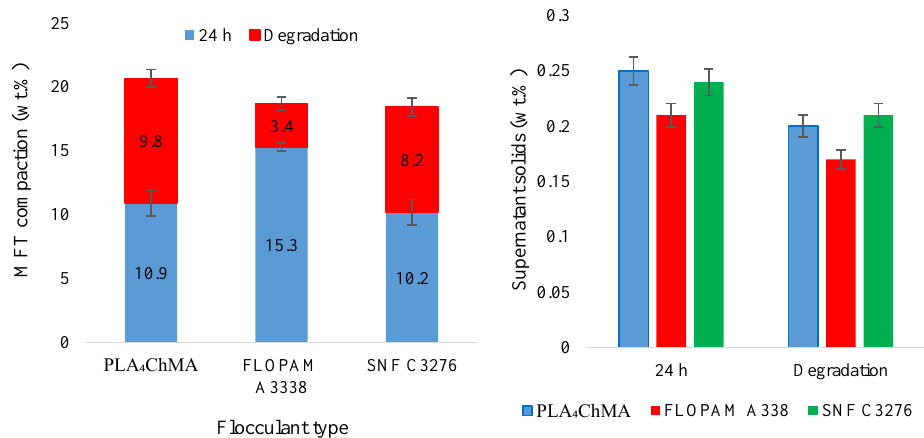
Figure 4. Comparison of compactions ( left ) and supernatant clarities ( right ) of 5.0 wt.% MFT in synthetic process water after treatments with various flocculants at 500 ppm.